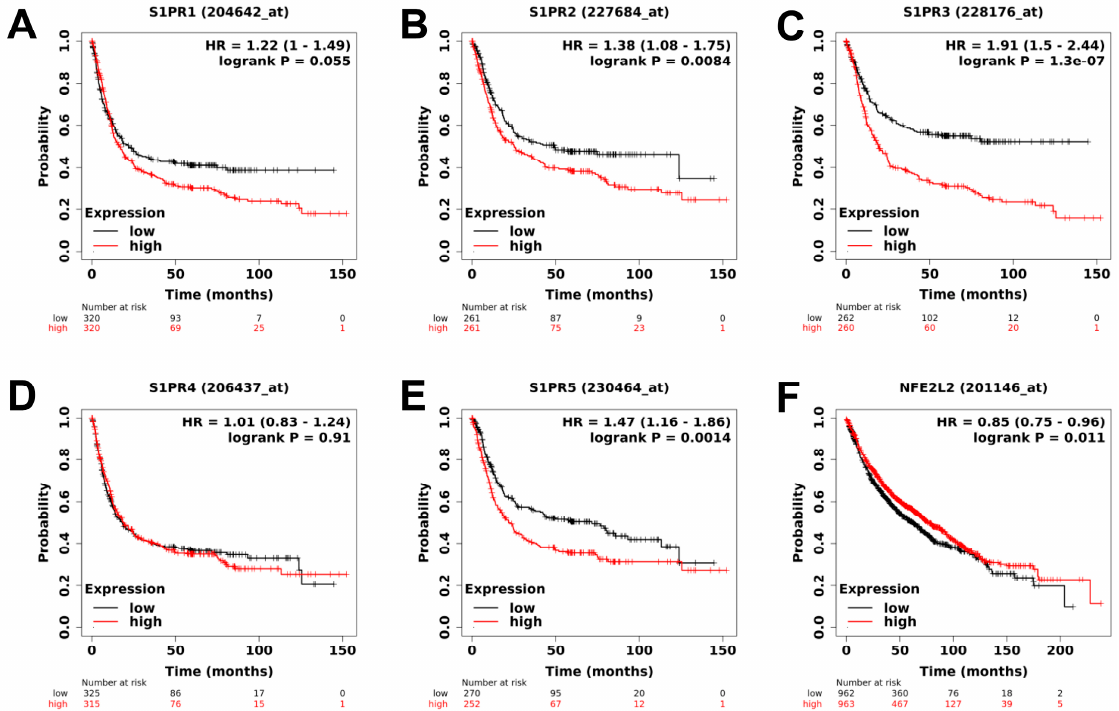
Figure 1. Analysis of publicly available clinical data of S1PR1, S1PR2, S1PR3, S1PR4, S1PR5, and NRF2 expression in lung cancer patients. ( A – E ) High expression of S1PR1, S1PR2, S1PR3, and S1PR5 are correlated with poor overall survival (OS) of lung cancer patients. Expression of S1PR4 is not correlated with OS of lung cancer patients. ( F ) NRF2 (NFE2L2) is correlated with good OS of lung cancer patients. Patients were stratified in low or high-expressing groups according to the expression of the different genes using the median value. The number of patients in each group is indicated below the graphs, p -values indicate the significance of survival difference between the groups of individuals by log-rank